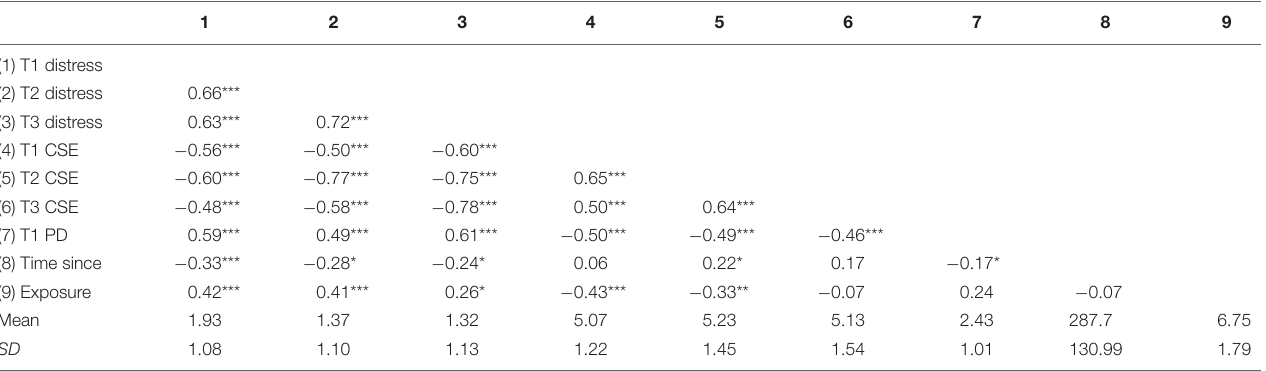
TABLE 3 | Pearson’s correlations, means, and standard deviations for the study variables for Study 2. 1 2 3 4